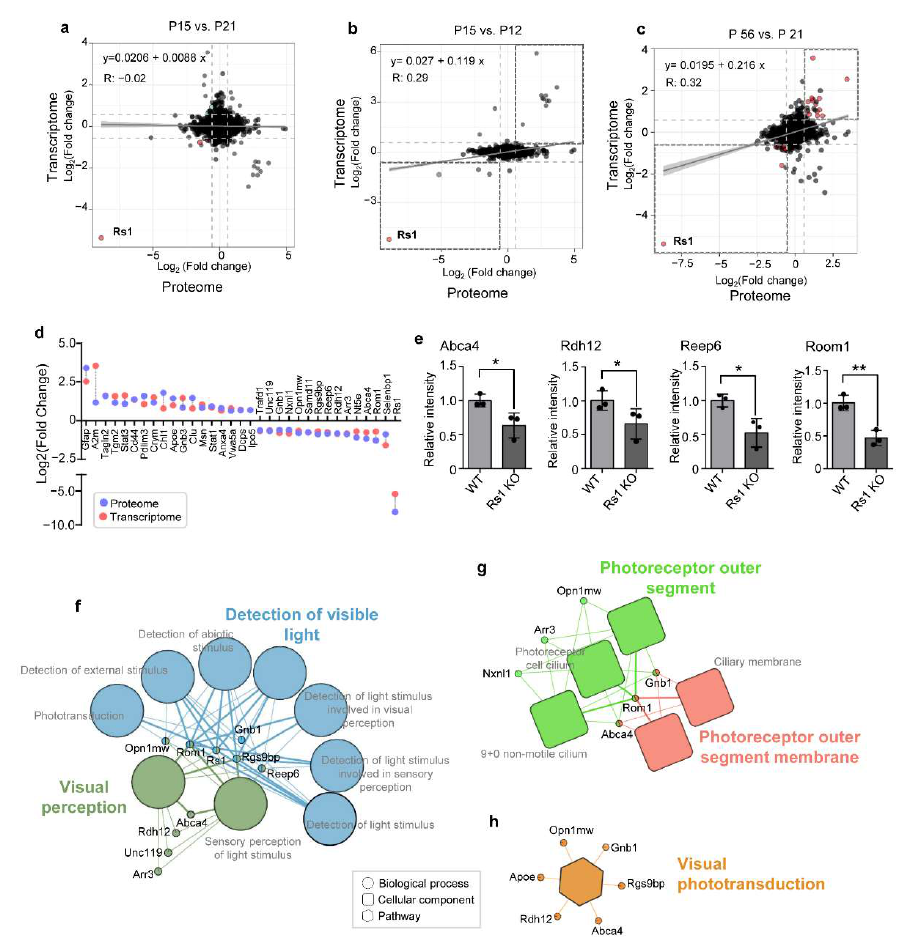
Figure 7. Combined transcriptomic–proteomic analysis of RS1-KO retinas. ( a – c ) Similarity correlation analysis of the altered proteome and published transcriptome at different postal days, including P15 vs. P12 ( a ), P15 vs. P21 ( b ), and P56 vs. P15 ( c ). ( d ) Changes in the differentially expressed proteins shared by proteome (P56) and transcriptome (P21) analysis. ( e ) Expression levels of mRNAs of Abca4, Rdh12, Reep6, and Room1. The results are shown as mean ± SD. Differences between groups were assessed by one-way ANOVA. ( f – h ) Cytoscape GoClue-based enrichment analysis, including the biological process ( f ), cellular component ( g ), and KEGG pathways ( h ) of the differentially expressed proteins shared by proteome (P56) and transcriptome (P21). Co-enrichment relations of a same color indicates that they are co-enriched in a same subnetwork. Corresponding enrichment results are annotated with the same color. * p < 0.05, ** p <